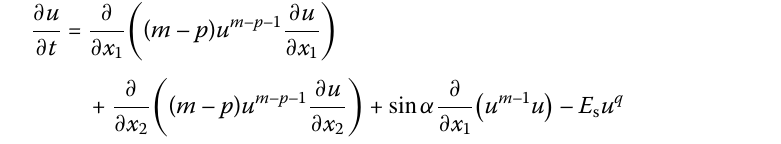
Figure 2 The 2-D model domain of the extended PME